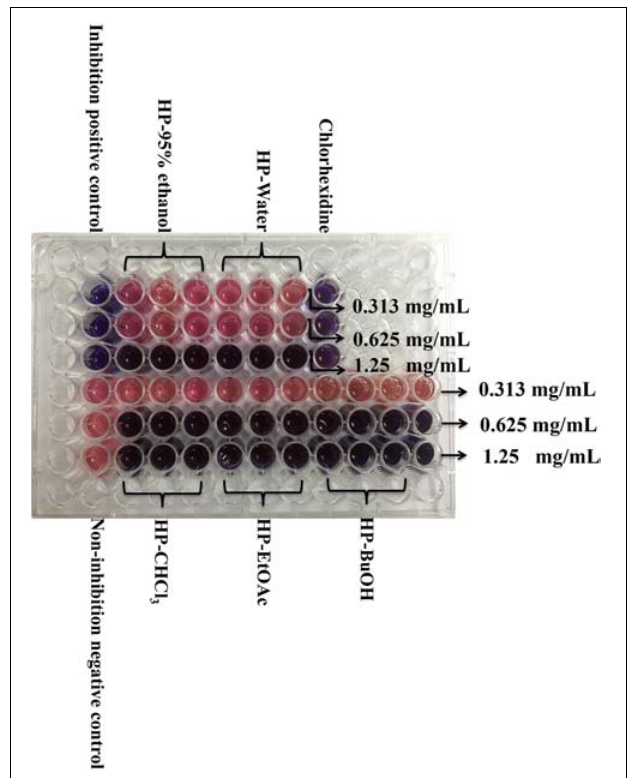
FIGURE 1 | Determination of MIC for extracts/sub-extracts against S. mutans. After incubation with resazurin sodium 24 h, the lowest concentration that could protect the color from changing to pink was determined as the MIC. Other changing color pictures are displayed in Supplementary Data Sheet